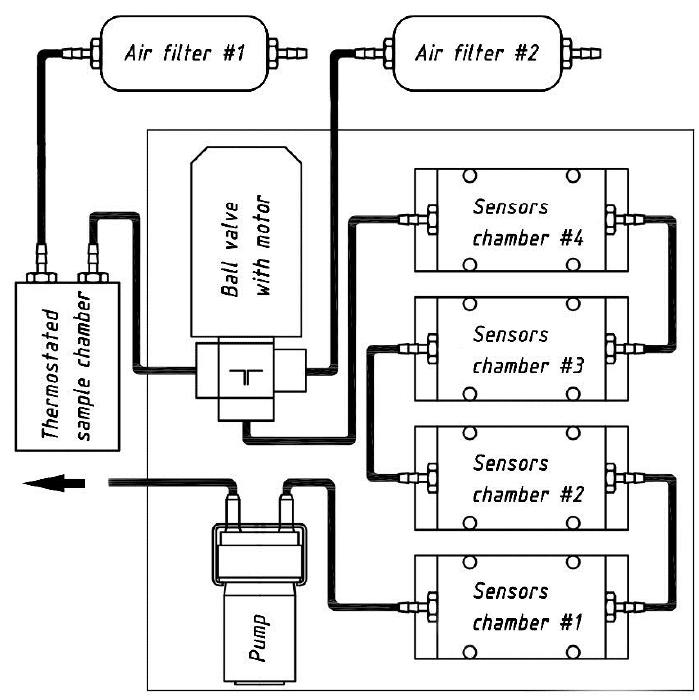
Figure 1. Pneumatic assembly of the electronic nose prototype.